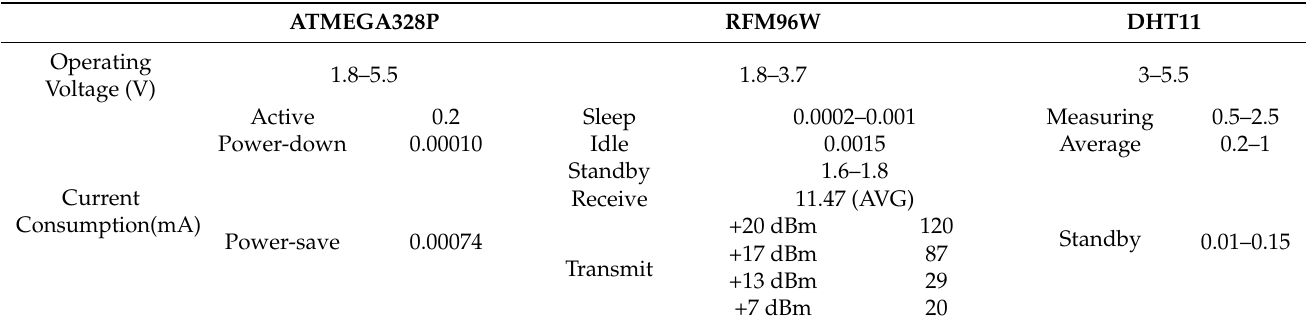
Table 2. The current and voltage characteristics of the WSTx components.